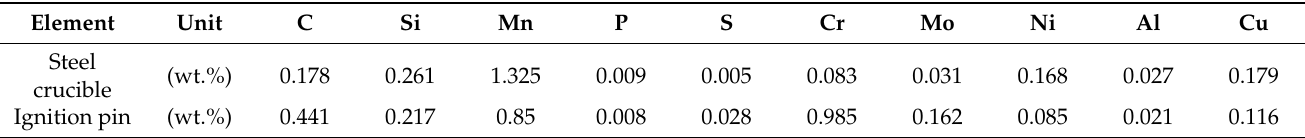
Table 5. Chemical composition of ignition pin and steel crucible.